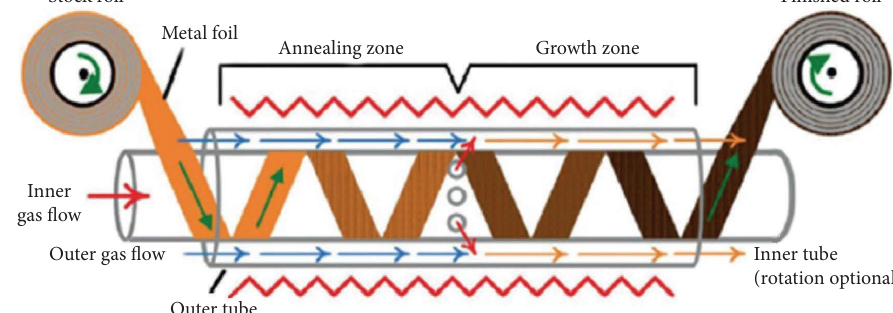
Figure 15: Roll to roll CVD graphene production [16].